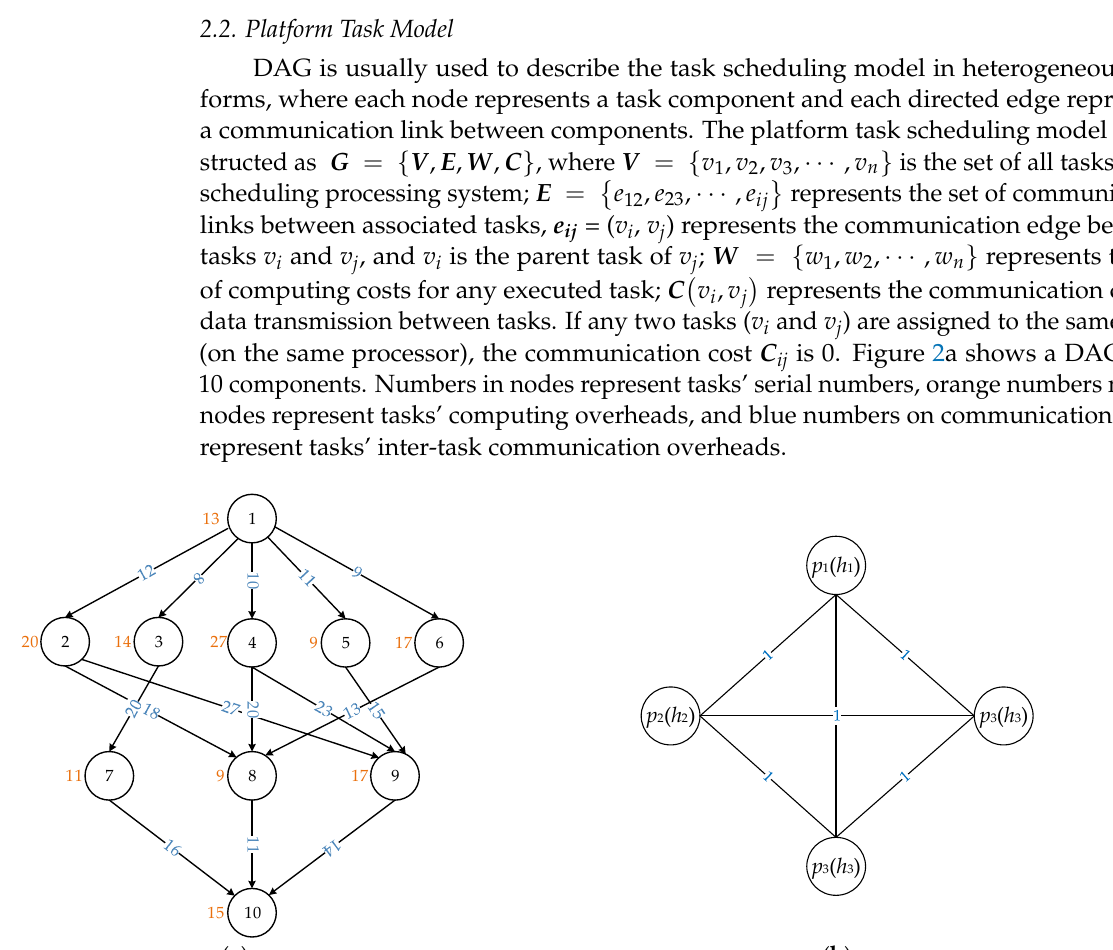
Figure 1. The software architecture of the heterogeneous signal processing platform.